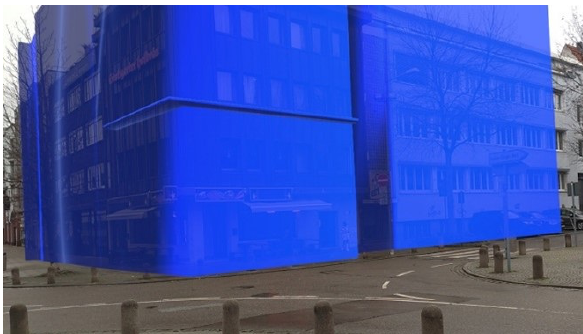
Figure 5. Alignment of the 3D building model occlusion mask with real environment. Rendered in blue color for better visualization.